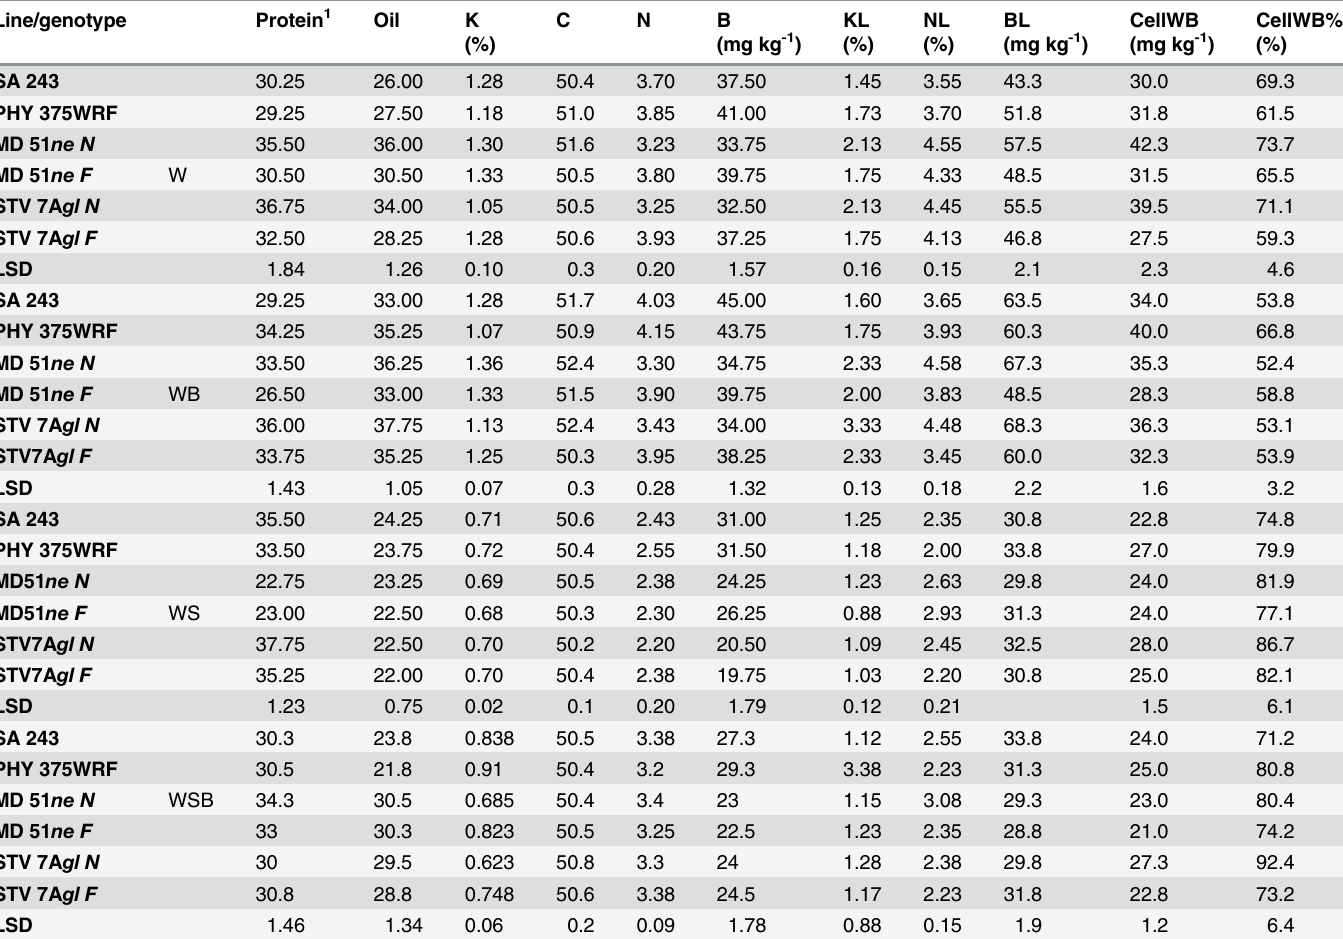
Table 3. Experiment 1: Effect of water (W) and foliar boron application (B) treatments on cottonseed nutrition (protein, oil, K, C, N, B) and nutrients (K, N, B) in leaves (L), and in cell wall B (CellWB), and cell wall B contribution to the total B (CellWB%) in near-isogenic lines expressing fuzzy (F) and fuzzless (N) seed